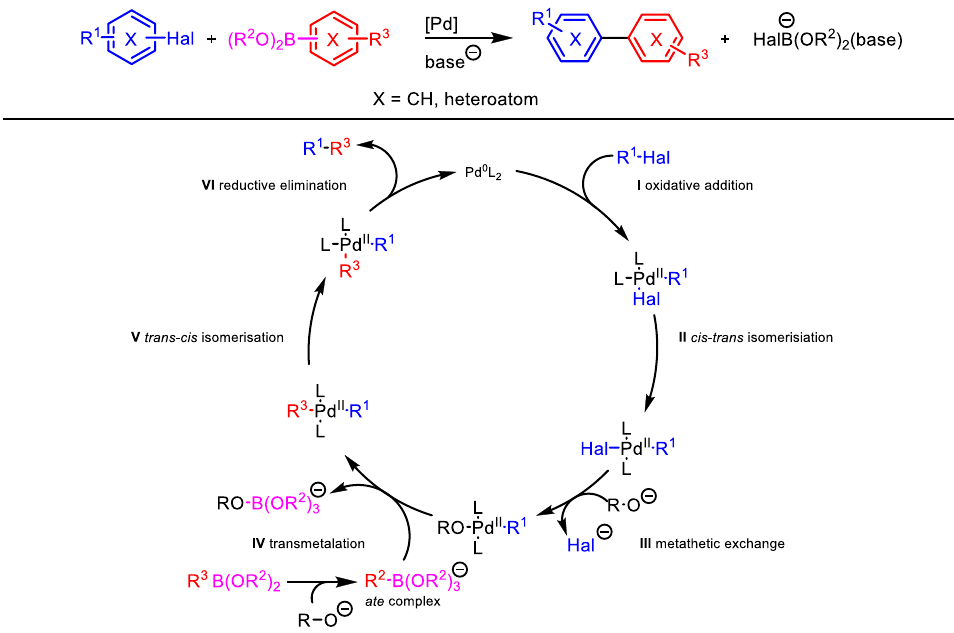
Figure 1. General scheme and mechanism of a Suzuki coupling.